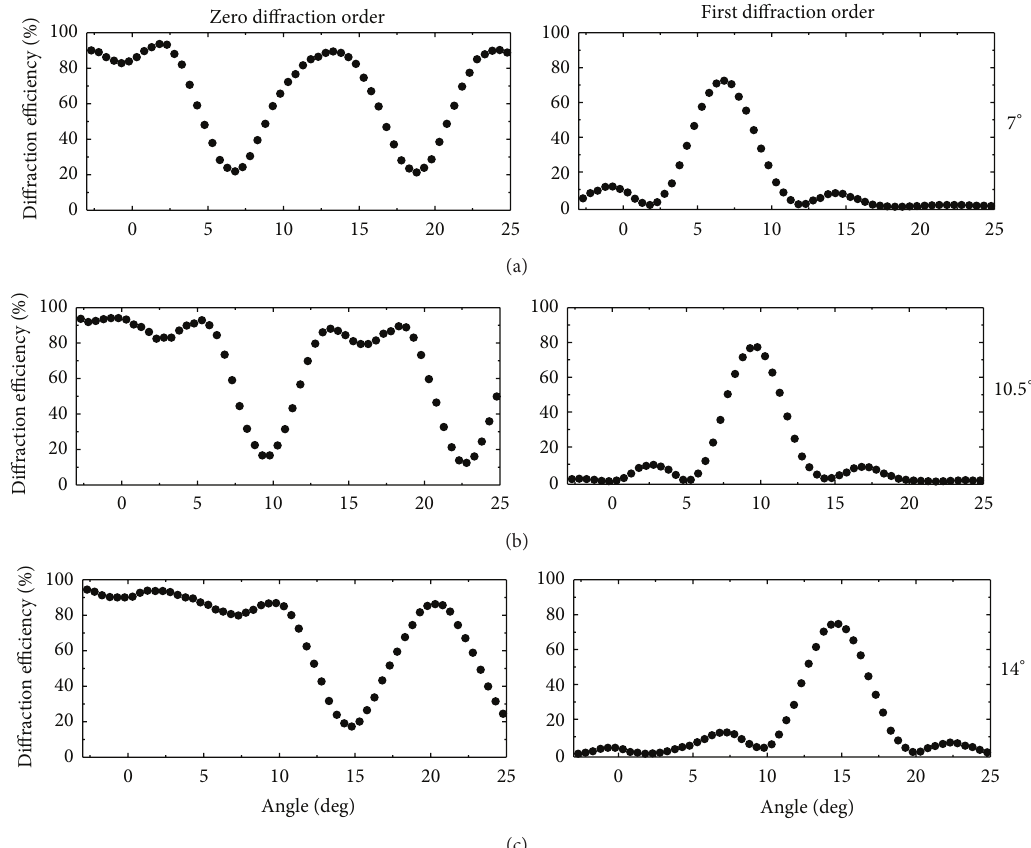
Figure 3: Angular selectivity curves for diffractive lenses with spatial frequency centred at 300 l/mm recorded in layers with thickness of 50 𝜇 m on a plastic flexible substrate, at range of angles: (a) 7 ∘ , (b) 10.5 ∘ , and (c) 14 ∘ before stacking.